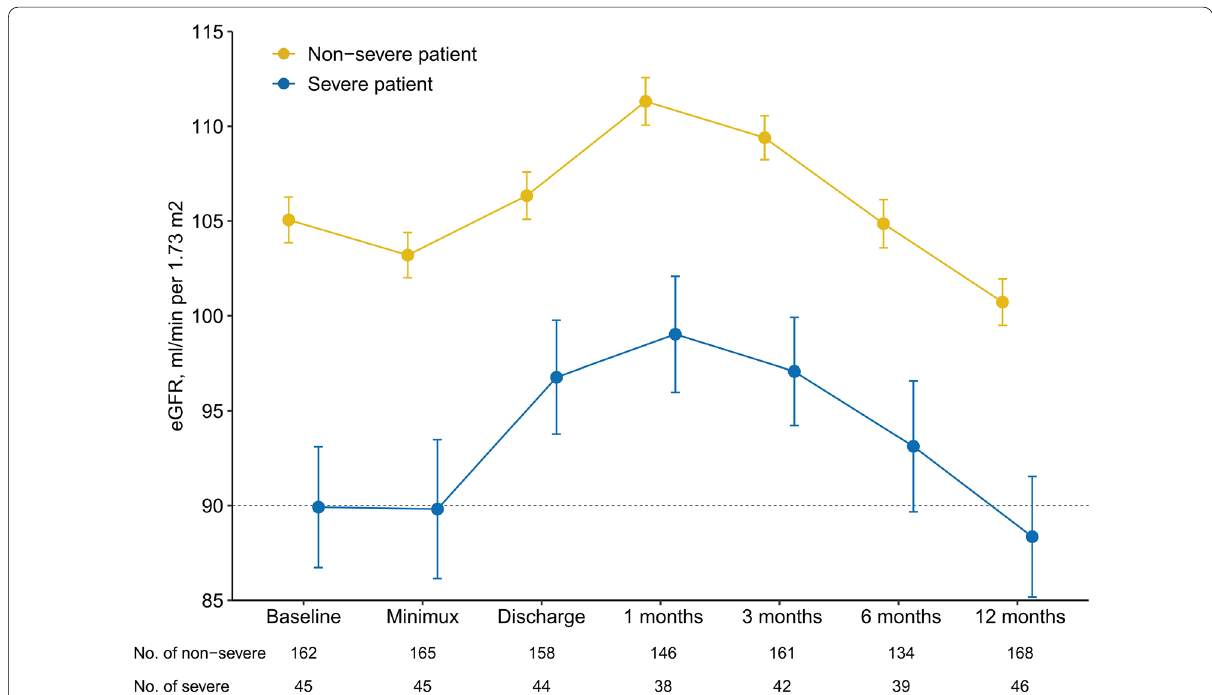
Fig. 4 Temporal changes in renal function according to eGFR analysis in recovery patients with different disease severity. Data are represented as mean standard error (SE) ±